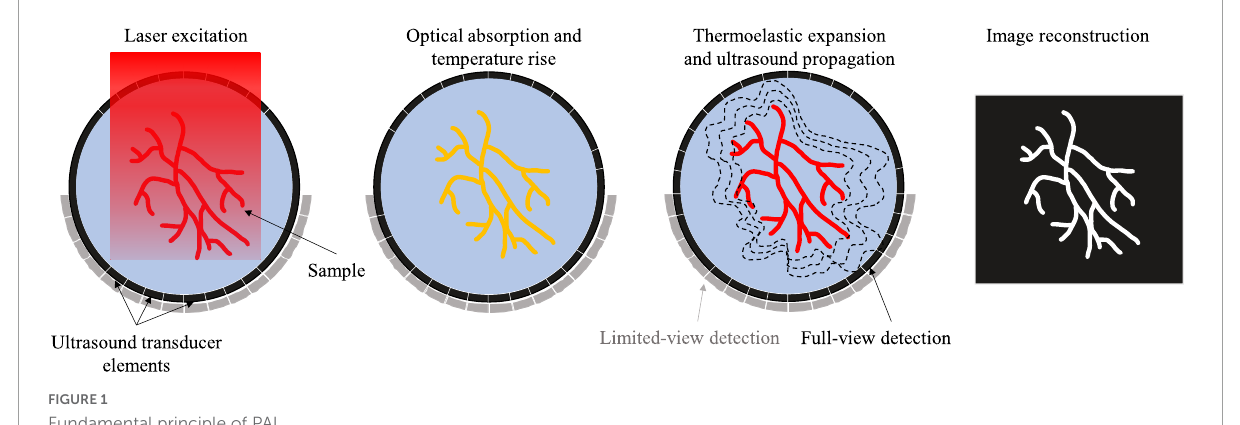
FIGURE1 Fundamental principle of